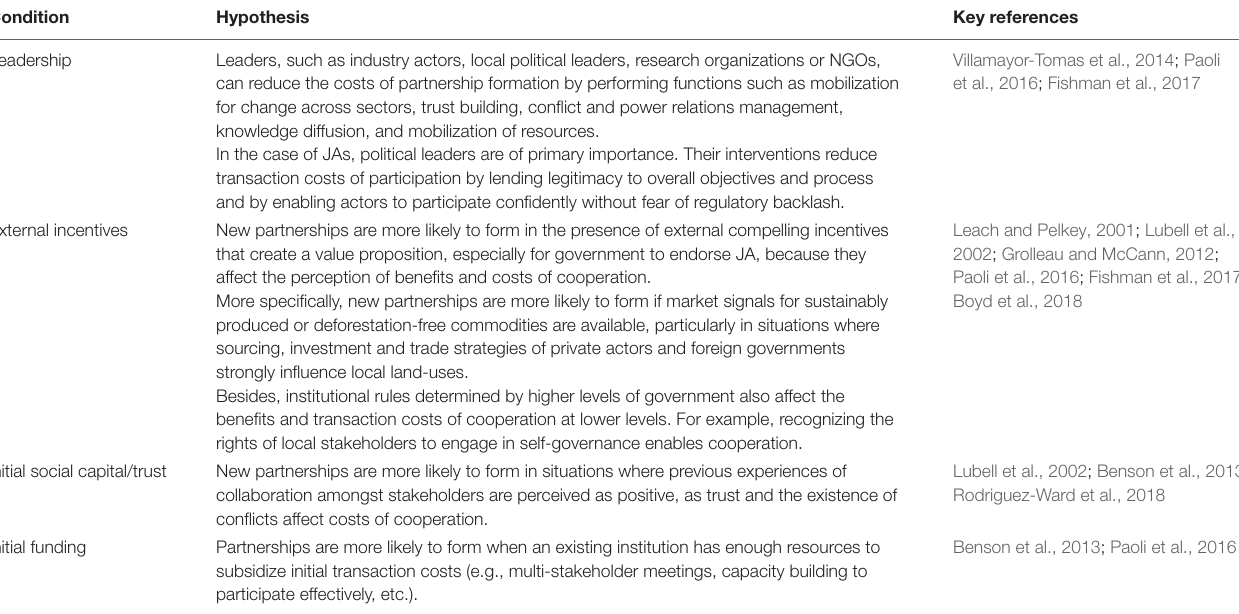
TABLE 1 | Key context-mechanism hypotheses for the emergence of collaboration in the case of